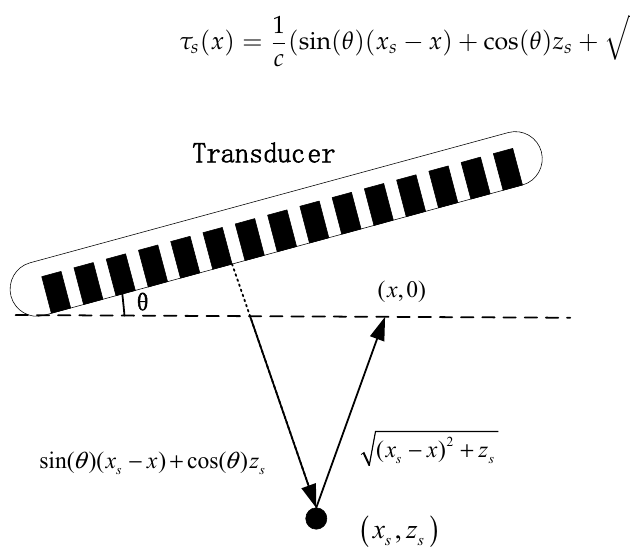
Figure 1. Scheme of route for the echo signal travelling from transmitter to receiver.